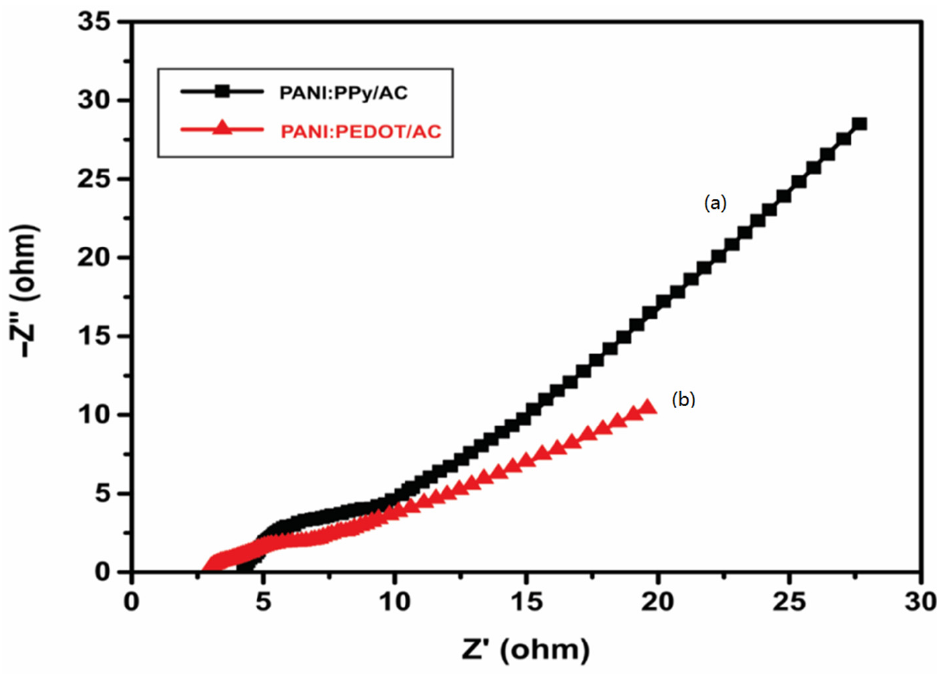
Figure 9. Nyquist plots of ( a ) PANI:PPy /AC composite and ( b ) PANI:PEDOT/AC composite within 5 mM of K 3 [Fe(CN) 6 ] plus 0.1 M KCl.